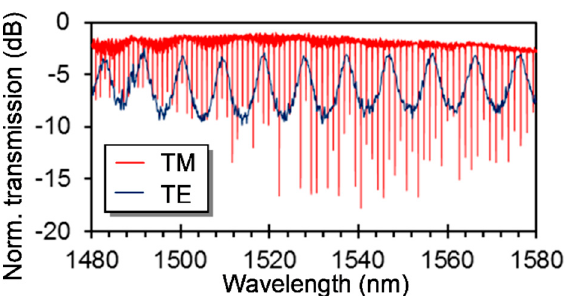
Figure 4. Measured spectra of a fabricated silicon photonic polarization multiplexing sensor.